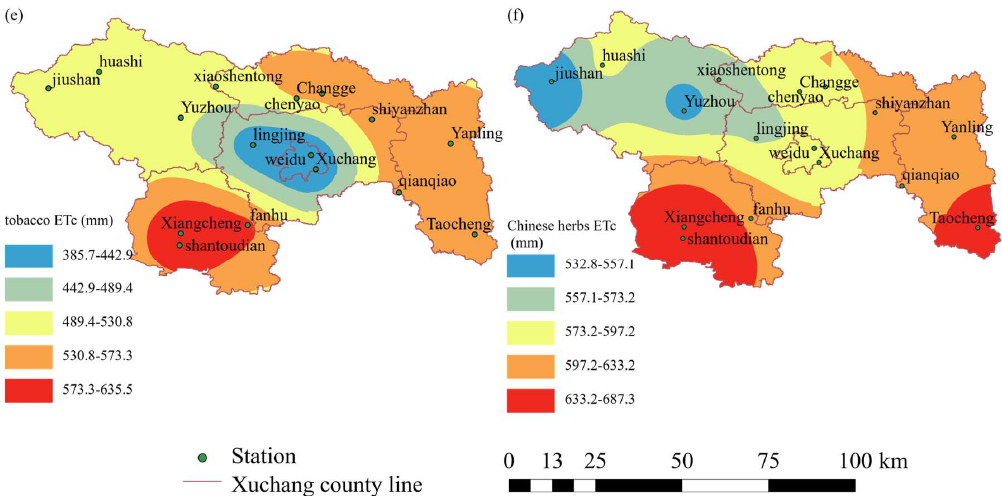
Figure 3. Spatial distribution of main crops water requirement, ( a – f ) represent the ET c (mm) of wheat, maize, soybean, flowers, tobacco and Chinese herbs, respectively.